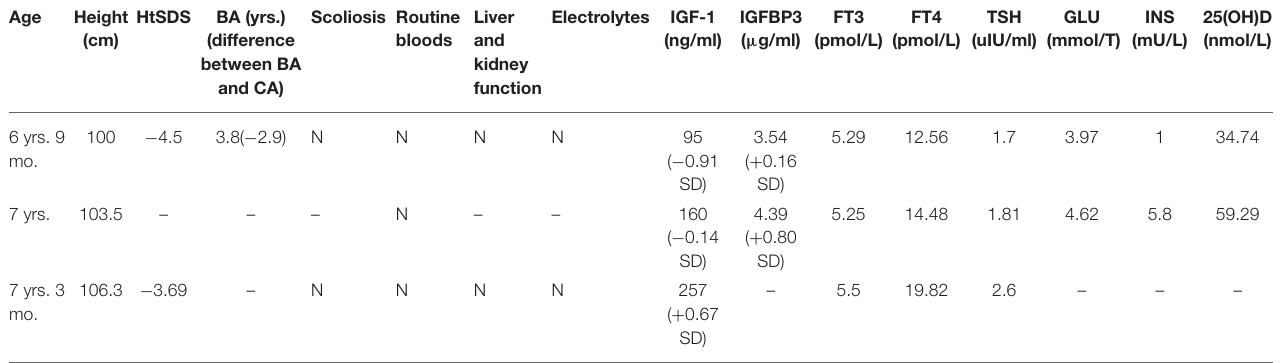
TABLE 1 | Follow-up data of the patient who was treated with rhGH, including age, height, differential, scoliosis, blood count, liver and kidney function, and electrolyte concentrations. Age Height HtSDS BA (yrs.) (cm)